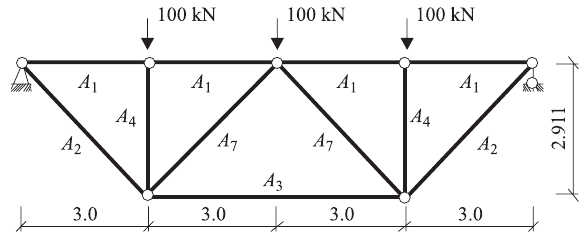
Fig. 4. The optimal truss structure for the first load case and for both the first and the second load cases